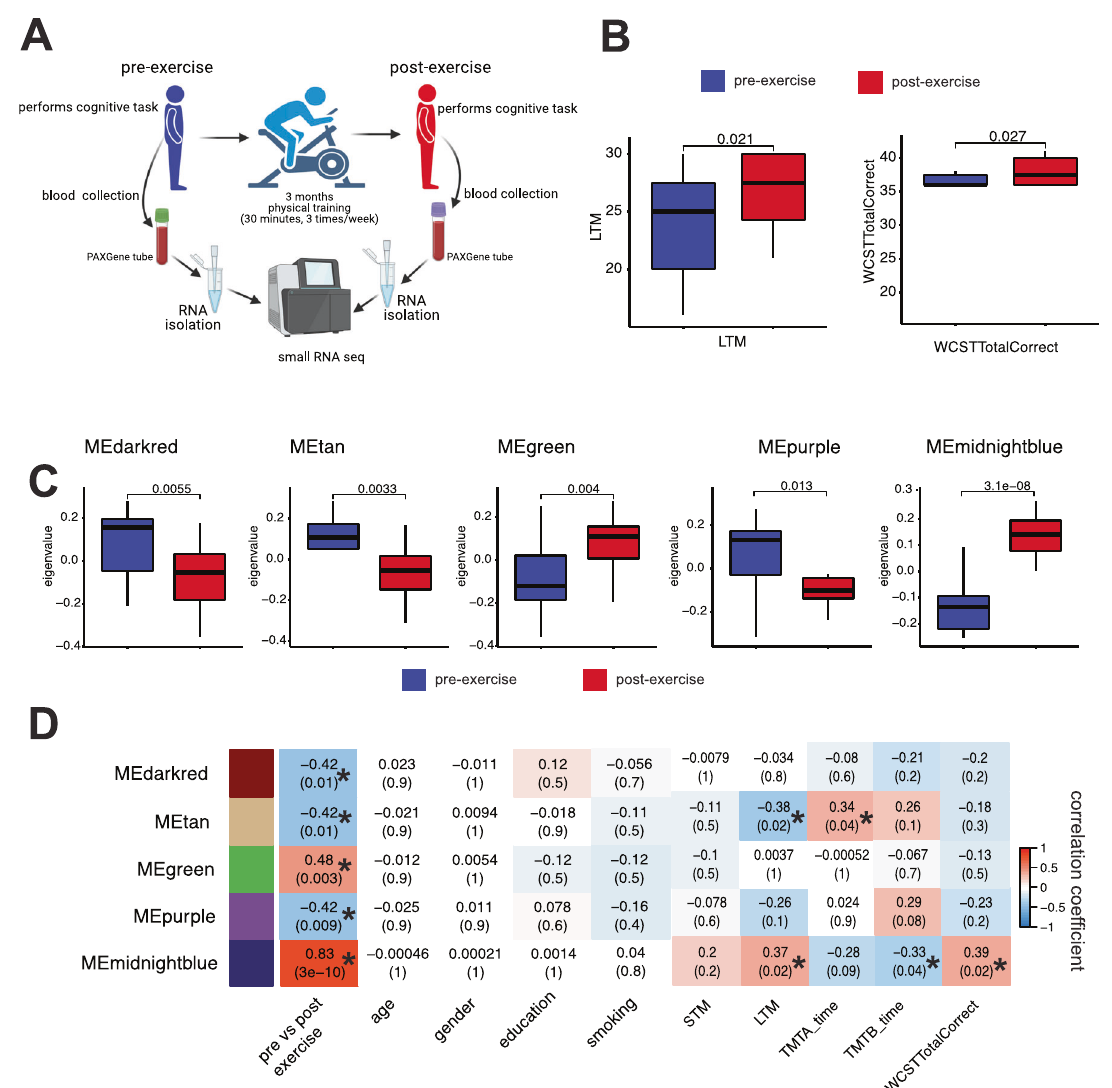
Fig. 1 Circulating miroRNAs are correlated to exercise-mediated cognitive improvement. A Experimental scheme. Healthy volunteers ( n = 19; 14 male and 5 females, 39 ± 10 years of age) participated in 3-month long physical exercise training. Cognitive performance was assessed using various psycho-cognitive tests prior (pre) and after (post) the experiment. Blood was collected at pre and post time points and RNA isolated from total blood was subjected to generate high-quality small RNAome pro fi le. B Left panel: Long-term memory (LMT) measured via the VLMT and performance in the WCST (right panel) as measured by the number of correct choices (TotalCorrect) was signi fi cantly increased when comparing pre- vs. post-exercise. C Box plots showing the eigenvalue-expression of fi ve microRNA co-expression modules (ME) that signi fi cantly differ when comparing pre- vs. post-exercise. D Heatmap showing a correlation between the eigenvalue-expression of fi ve microRNA co-expression modules from ( C ) and the clinical traits. Each row represents a ME, each column corresponds to a trait. Each cell shows the corresponding correlation, p values are shown in brackets. The values are color-coded based on direction and degree of correlation. Blue represents negative correlation and red represents positive correlation. * p < 0.05 was considered signi fi cant. The horizontal line in the box plot represents the median, the box spans 25 and 75% quantile, and the whiskers represent the smallest and largest values in the 1.5× interquartile